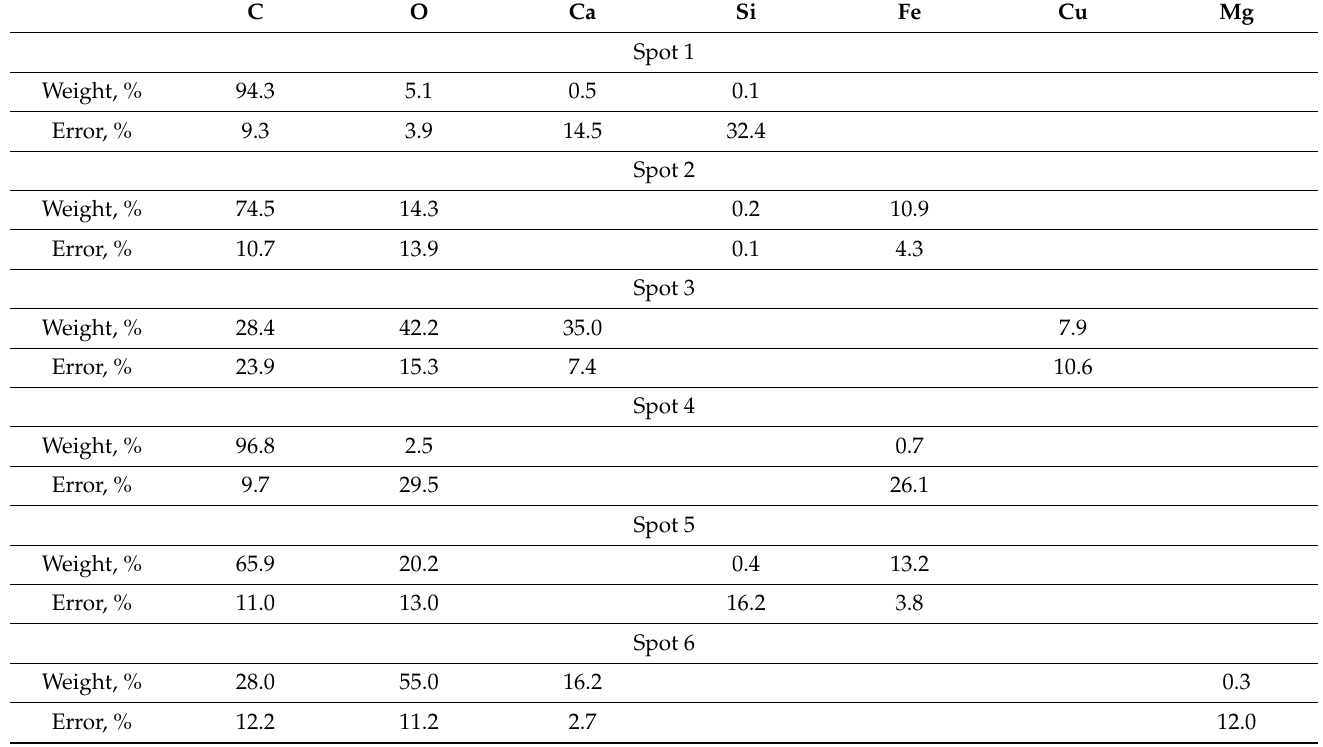
Table 4. Results of EDS analysis of sample